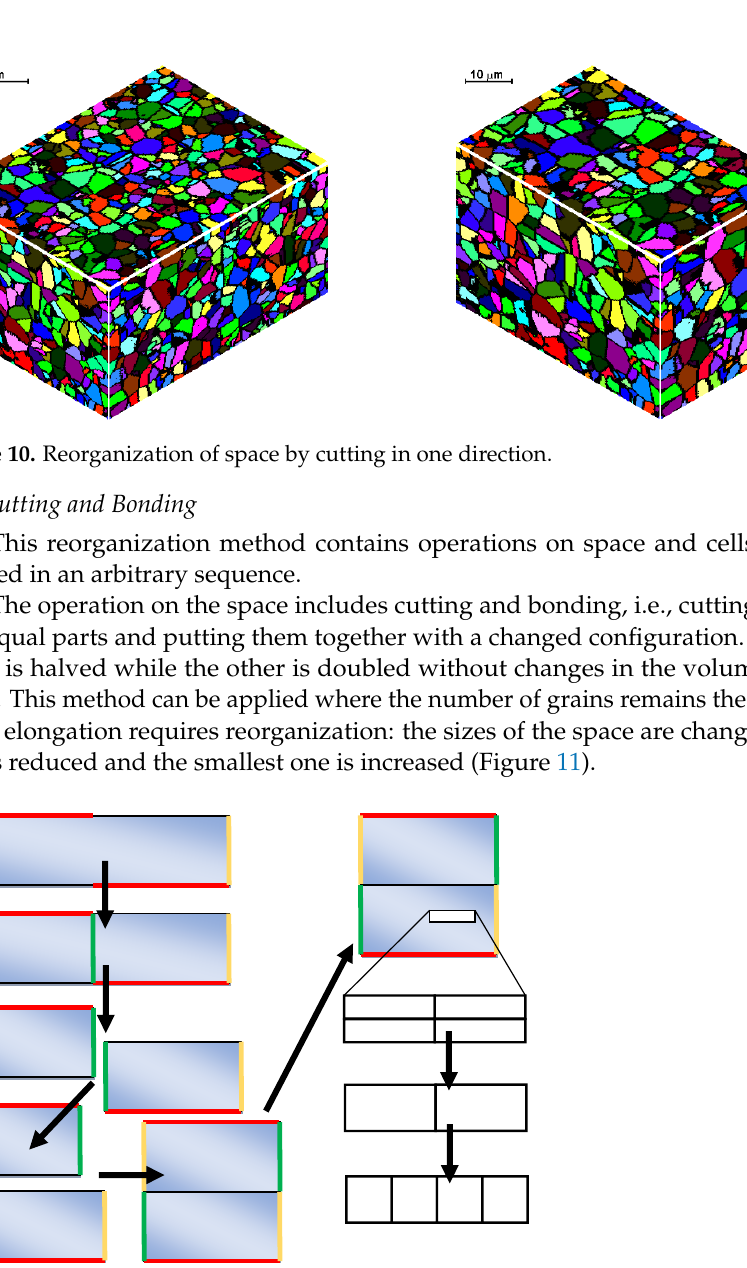
Figure 11. Modeling space cutting and bonding and boundary conditions before and after space reorganization.